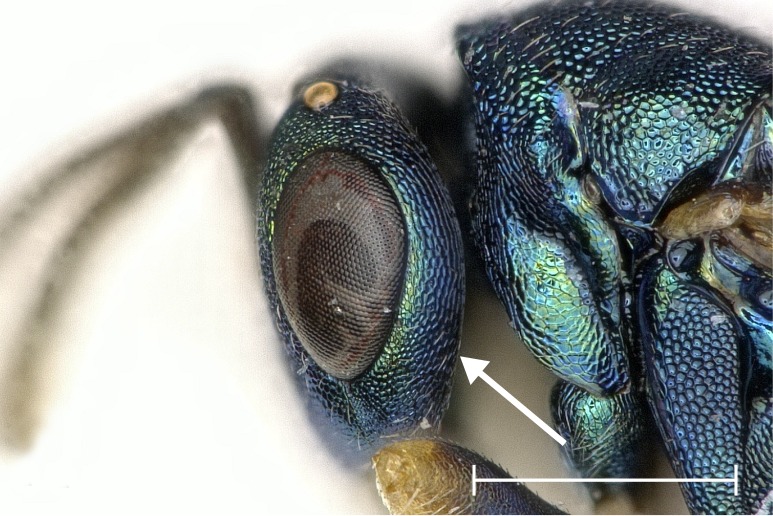
Head, lateral view.